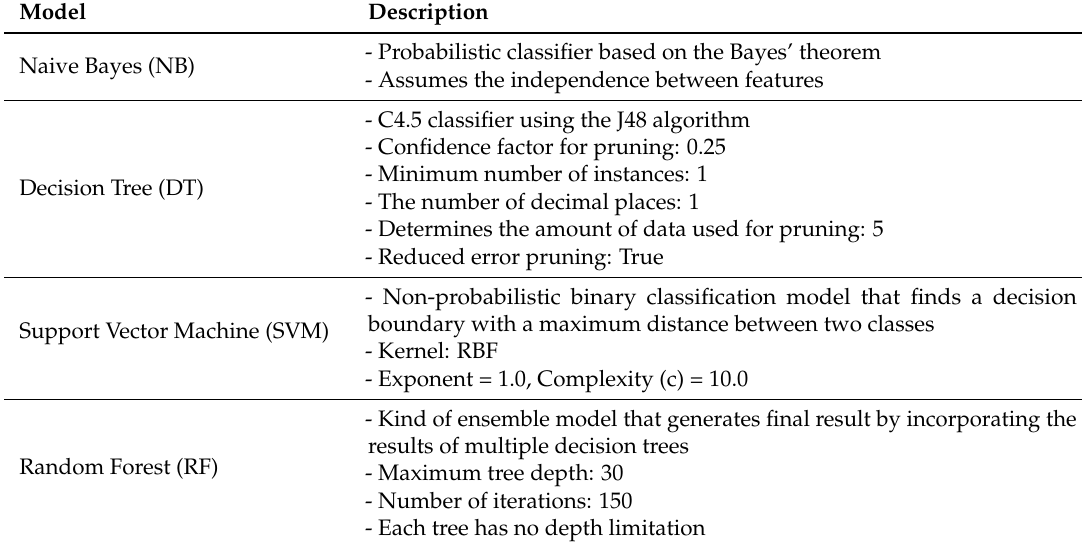
Table 2. The description of the traditional machine learning models and the parameter settings.